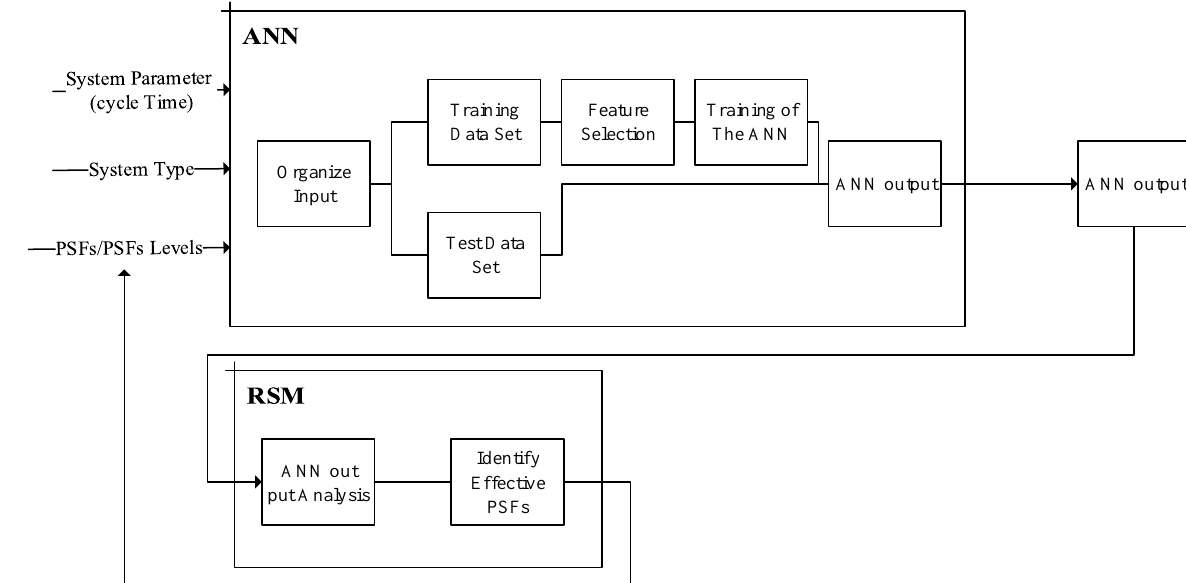
Fig. 2. The proposed framework to assess the human reliability .